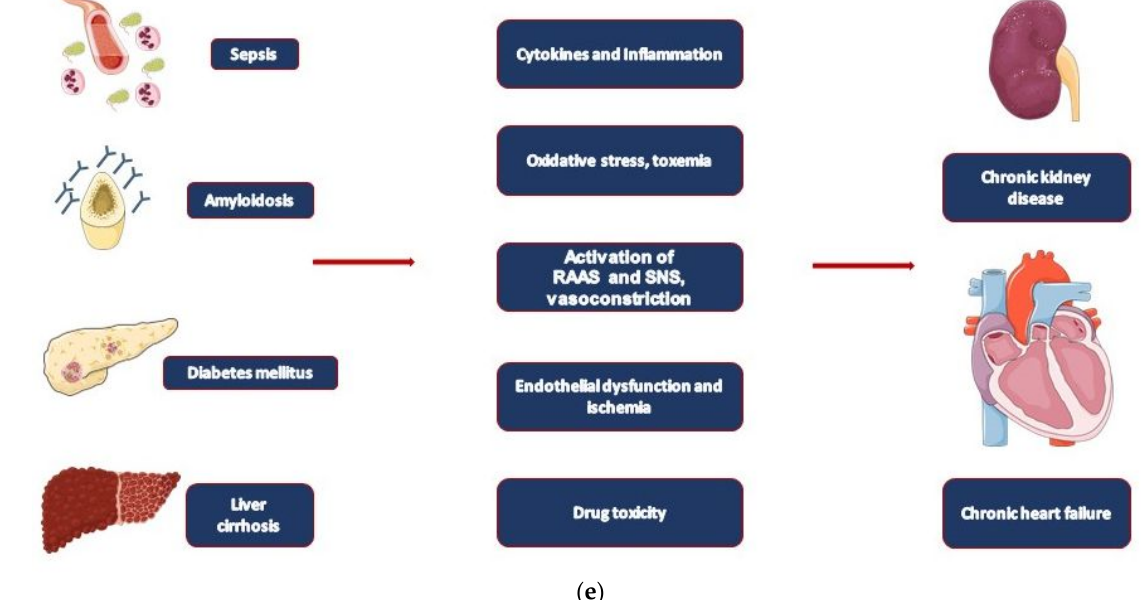
Figure 1. Pathogenic pathways involved in the five CRS types.